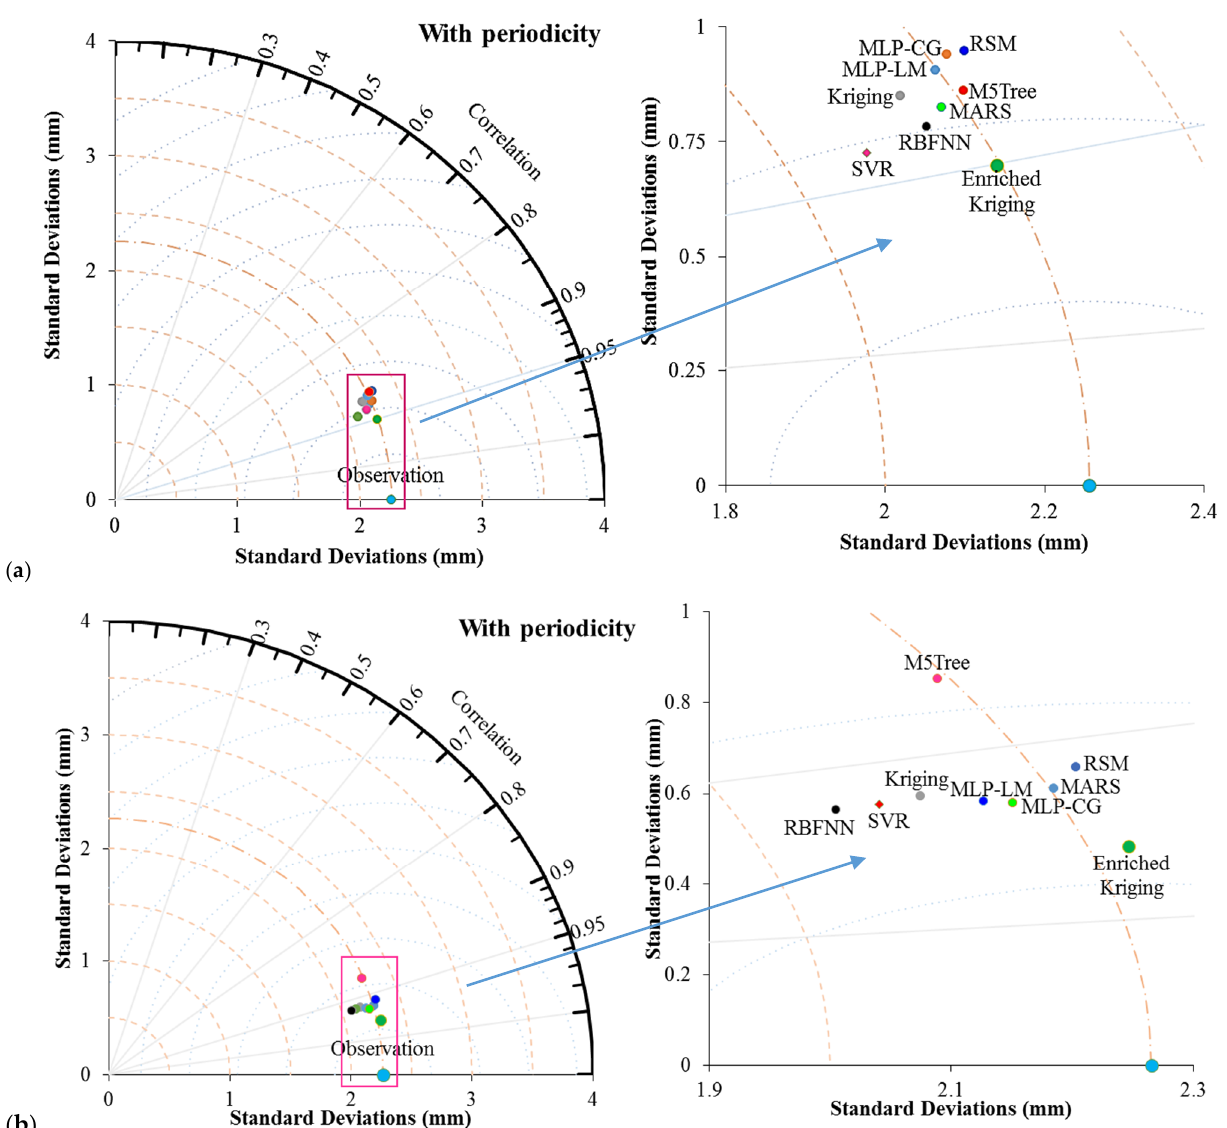
Figure 9. Taylor diagram for different models in the testing phase of ( a ) Adana station ( b ) Antakya station.